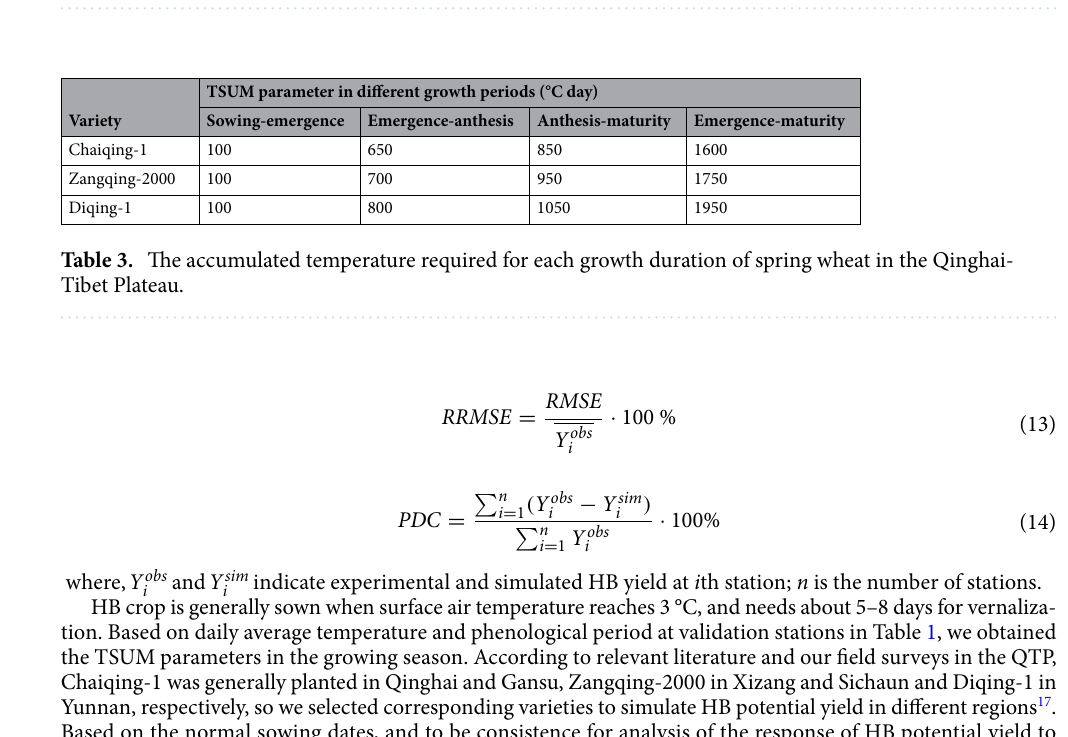
Table 2. Meteorological stations in different effective accumulated temperature ranges of the Qinghai-Tibet Plateau.